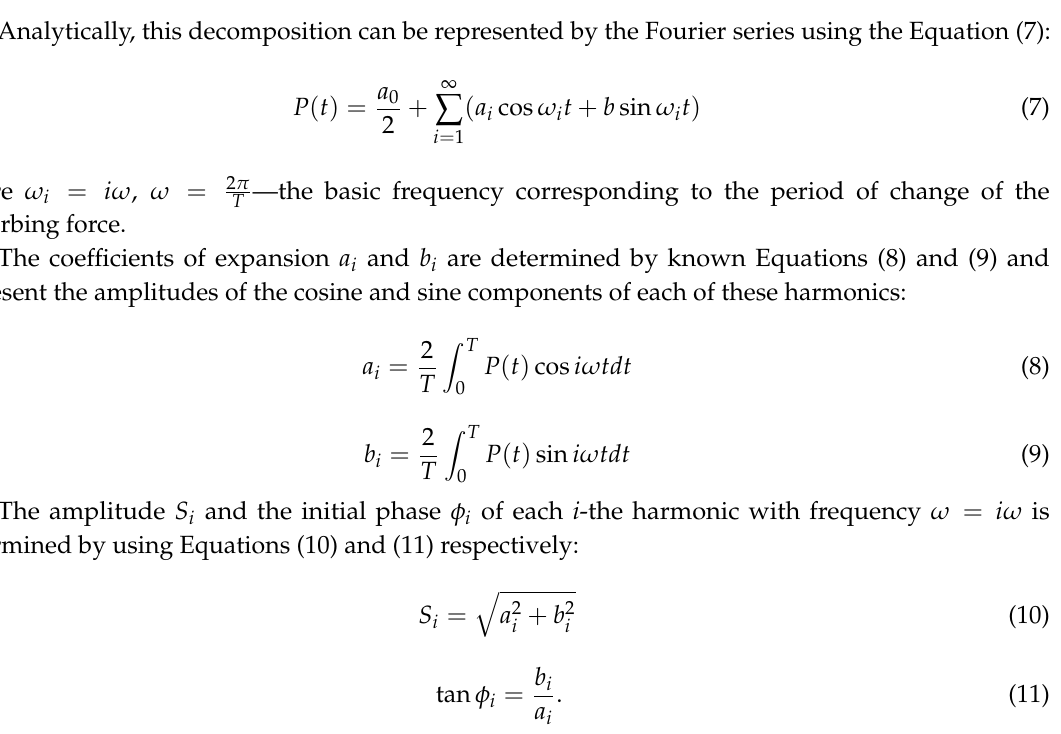
Figure 5. Decomposition of a periodic curve into a harmonic